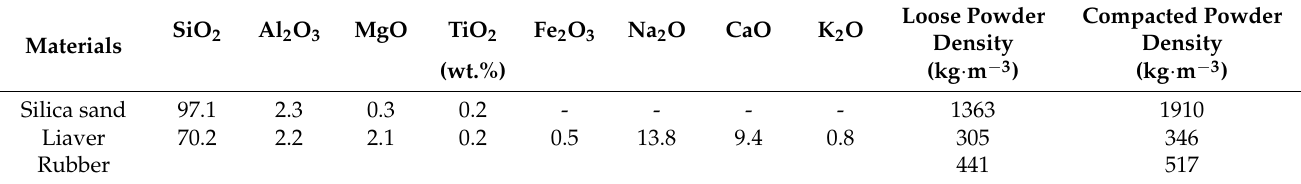
Table 4. The chemical composition and physical properties of silica sand, Liaver, and rubber